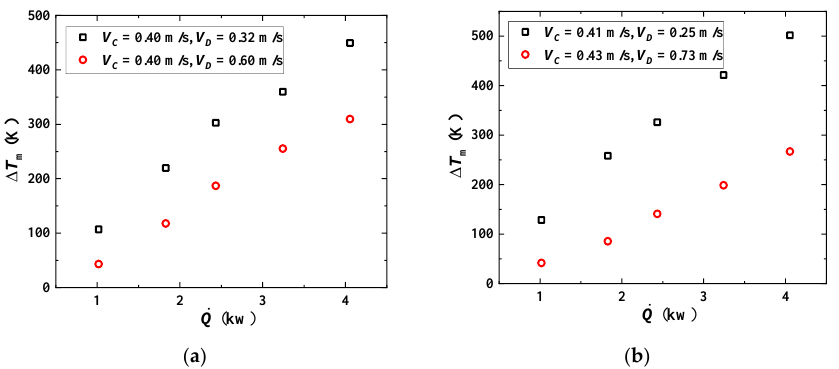
Figure 6. Variation in maximum temperature rise with HRR under similar velocities on ramp C: ( a ) φ = 10%; ( b ) φ = 20%. Figure 7 selects the maximum temperature rise data when the velocities of the D ramp were similar and the velocities of the C ramp were different. When φ = 20%, Q = 4.05 kW, the ramp C velocities were 0.37 m/s and 0.46 m/s, and the maximum temperature was 405 K while the minimum was 317 K. The longitudinal ventilation velocity in ramp C also caused a change in the maximum temperature rise.